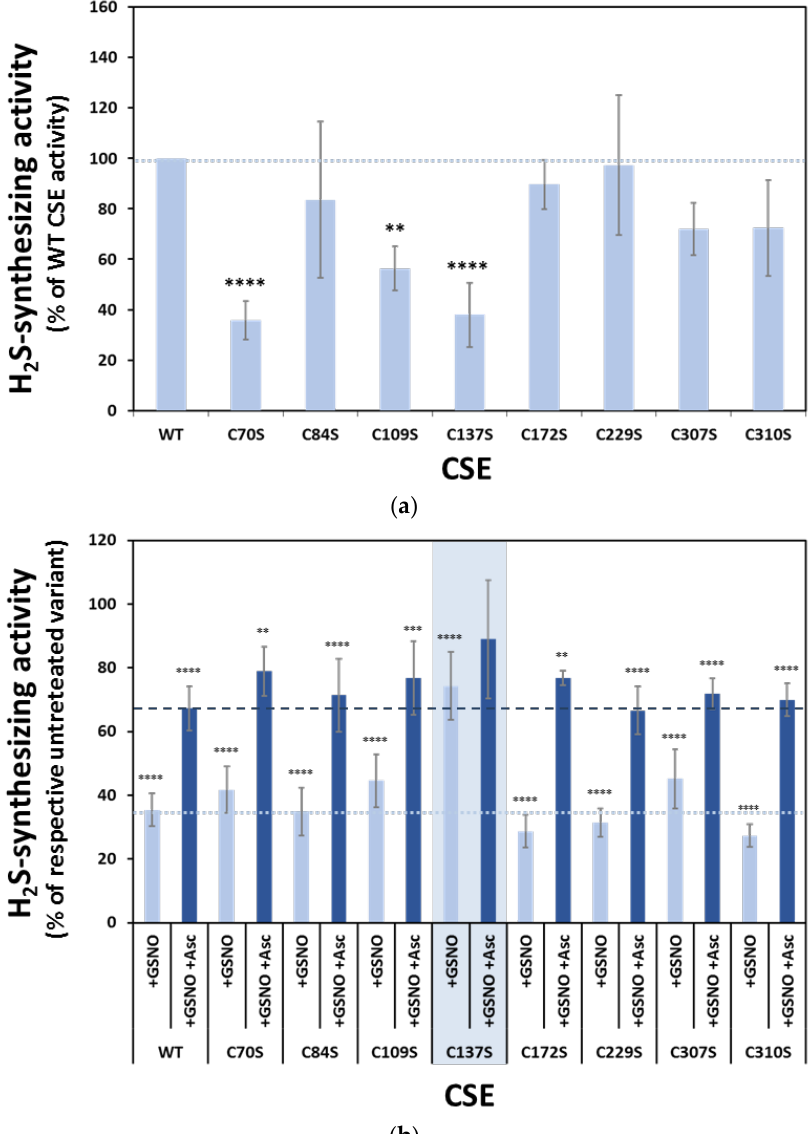
Figure 5. Effect of Cys-to-Ser substitutions on CSE H 2 S-synthesizing activity and GSNO-inhibition. ( a ) Comparison of H 2 S production by untreated WT CSE and Cys-to-Ser variants. Relative activities were measured as described in the legend to Figure 1 and normalized to the WT CSE. Error bars represent the standard error (SE), where n ≥ 4. ( b ) Effect of S -nitrosation on the enzymatic activity of WT CSE and Cys-to-Ser variants. Histograms represent the relative activities of each variant after GSNO treatment (+GSNO) or the same followed by ascorbate reversal (+GSNO +Asc), normalized to the respective unreacted CSE variant. Error bars represent the standard error (SE), where n ≥ 4. Differences between groups were assessed by one-way ANOVA: **** p < 0.0001, *** p < 0.001, ** p < 0.01.